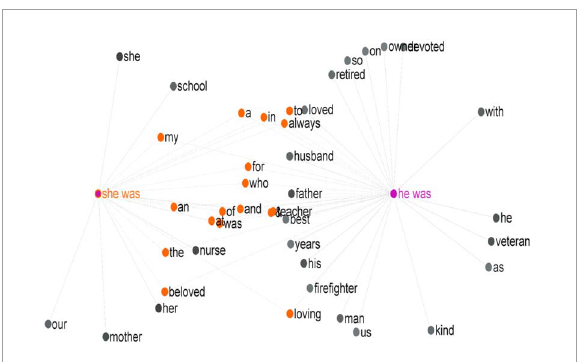
FIGURE6 Collocates of she was and he was in the FoC as generated by